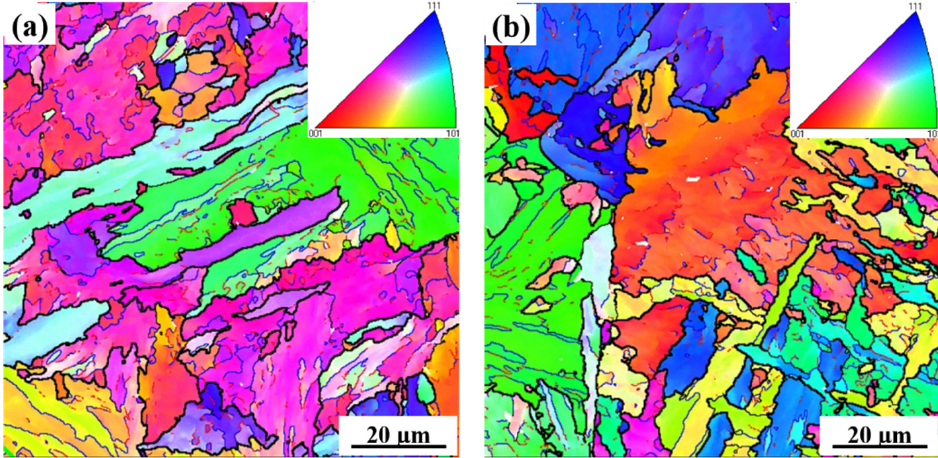
Figure 7. Orientation image maps of microstructure in normal direction in samples simulated with a heat input of 200 kJ/cm with ( a ) 0.073% and ( b ) 0.110% Nb. Table 6. Percentage of different grain misorientation angles corresponding to samples shown in Figure 7.